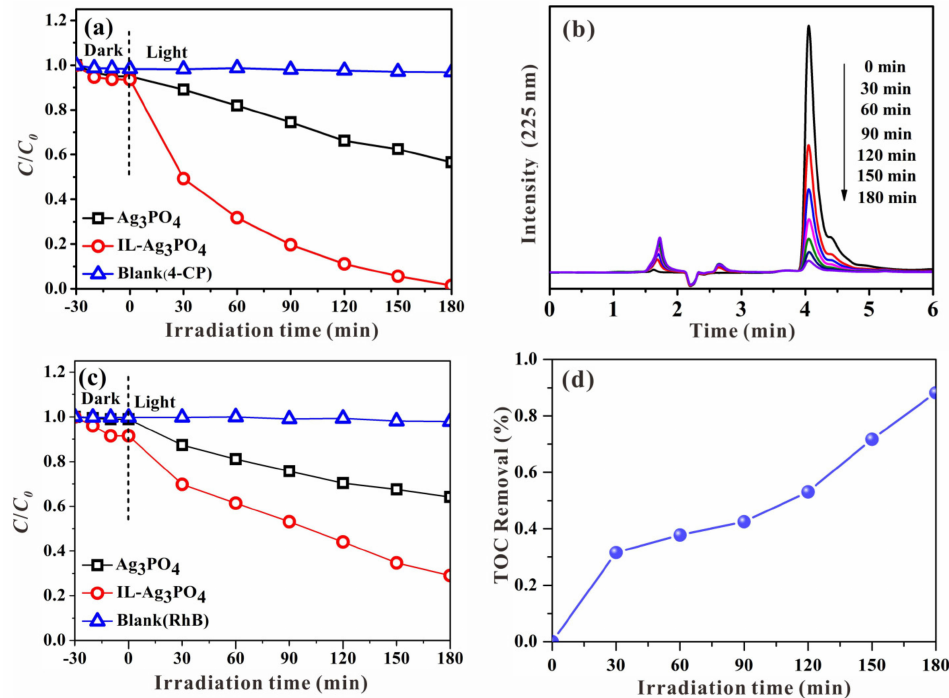
Figure 5. Photocatalytic degradation rate of ( a ) 4-CP and ( c ) rhodamine B (RhB) over different samples under visible light irradiation; ( b ) HPLC spectra and ( d ) TOC removal (relative to C 0 ) for photodegradation of 4-CP over IL-Ag 3 PO 4 under visible